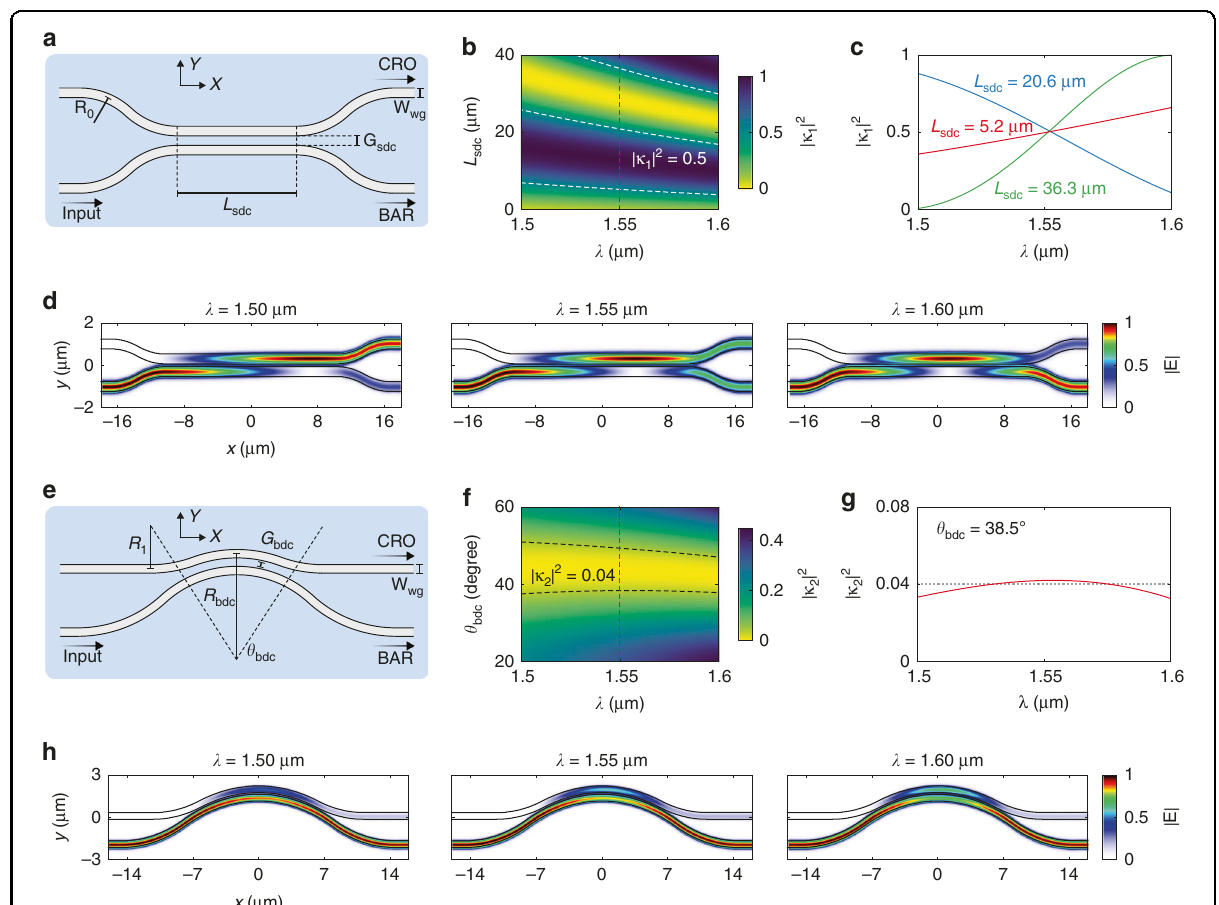
Fig. 3 Dispersion engineering for couplers. a Schematic layout of the straight directional coupler (SDC) with key parameters labeled. b Calculated inter-resonator coupling strengths (| κ 1 | 2 ) with varying coupling lengths ( L SDC ) and wavelengths. The white lines represent | κ 1 | 2 = 0.5, whereas the red line indicates the central wavelength. c Calculated | κ 1 | 2 with three selected L SDC . d Calculated light propagation pro fi les for SDCs. e Schematic layout of the bent directional coupler (BDC) with key parameters labeled. f Calculated external coupling strengths (| κ 2 | 2 ) with varying coupling angles ( θ BDC ) and wavelengths. The black lines represent | κ 2 | 2 = 0.04, whereas the red line indicates the central wavelength. g Calculated | κ 2 | 2 with θ BDC = 38.5°. The dashed line depicts the target | κ 2 | 2 . h Calculated light propagation pro fi les for